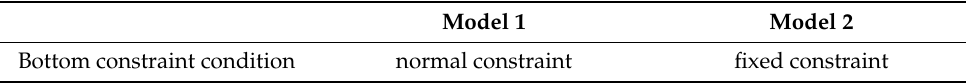
Table 5. Models of the different boundary conditions.